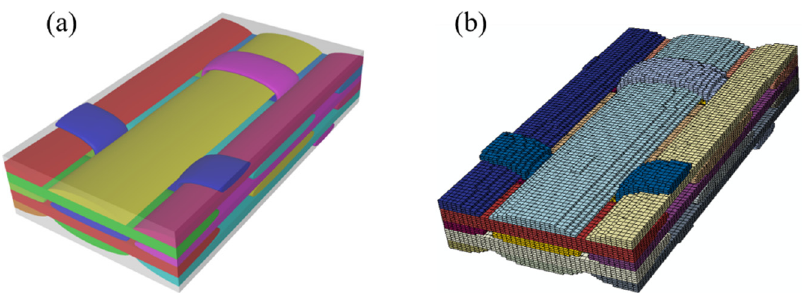
Figure 3. Textile geometry ( a ) and voxel mesh ( b ) of the three-dimensional orthogonal woven composites.